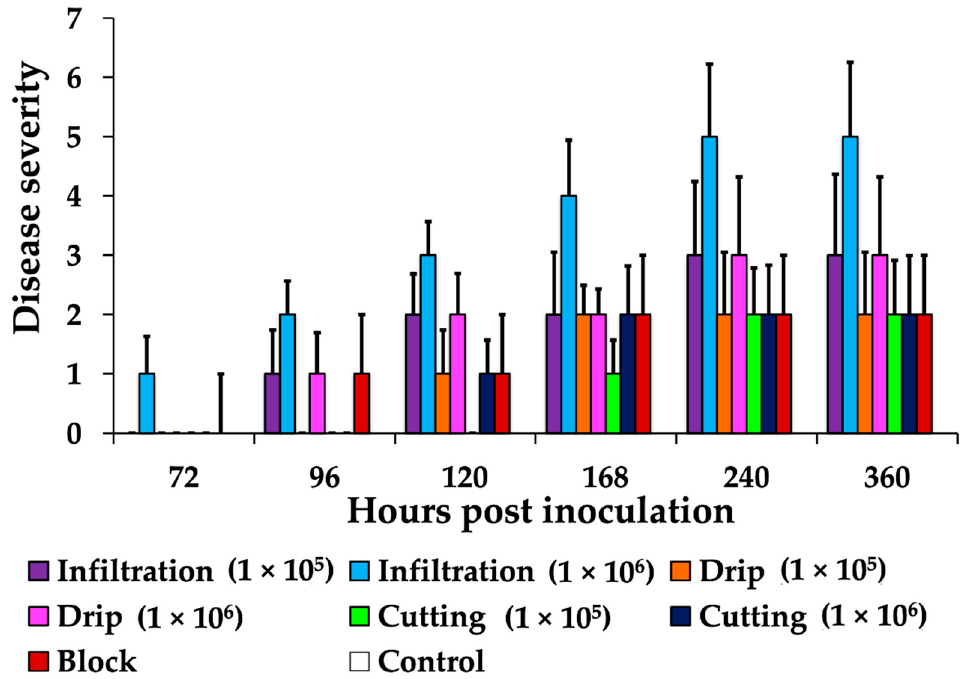
Figure 3. Disease severity in O × G hybrid seedlings inoculated with T. paradoxa suspensions (1 × 10 5 and 1 × 10 6 endoconidia mL − 1 ) using local infiltration, scissor cutting, drip, and agar blocks. In all, nine replicates were included for each time. No increased disease severity was observed after 240 hpi with any of the methods.